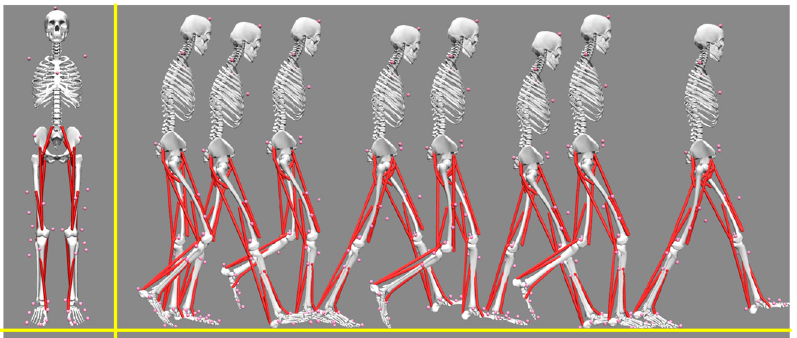
Figure 4. Walking simulation of muscle–bone model.